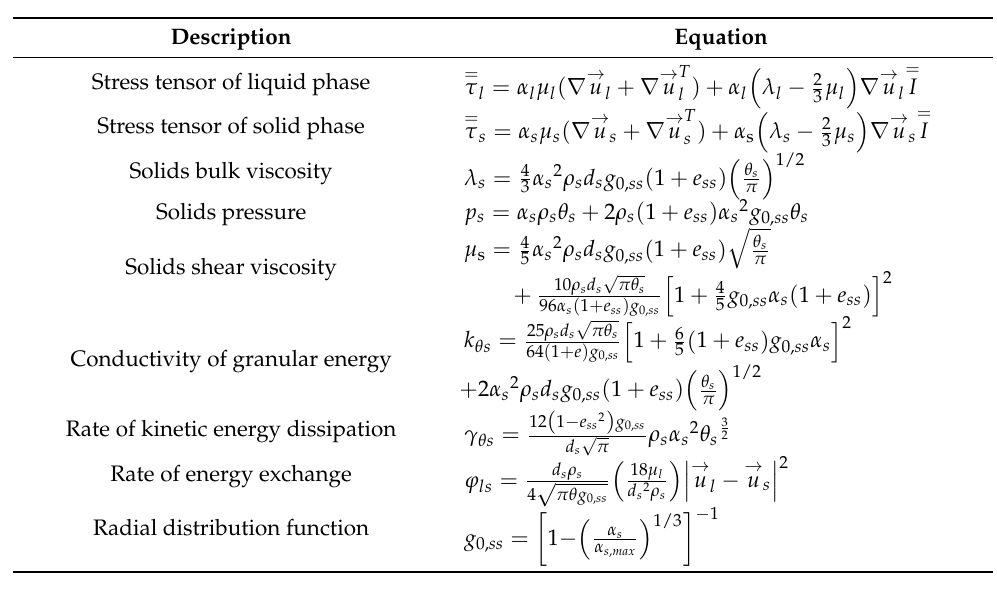
Table 3. Equations for the KTGF